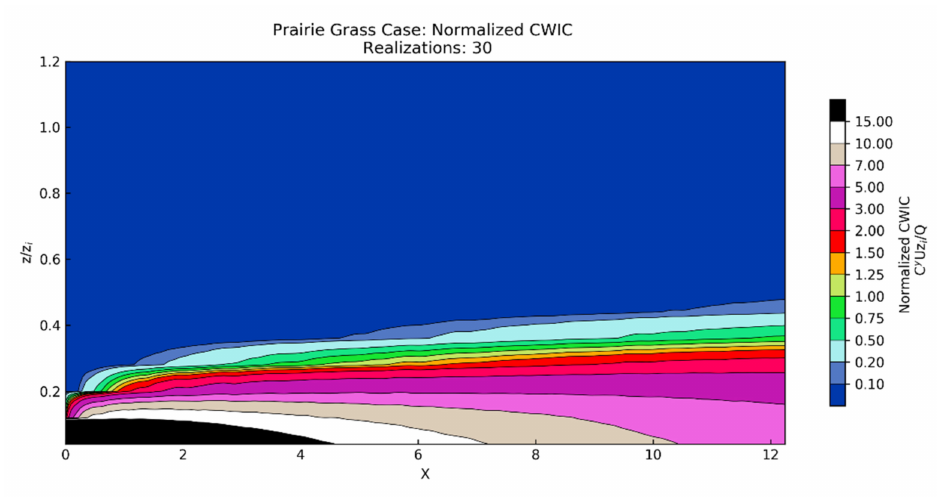
Figure 12. Normalized crosswind integrated concentration as a function of the downwind distance from the release location, for the slightly ( top ), moderately ( middle ), and extremely ( bottom ) sta- ble conditions. Each plot represents the average CWIC from 30 individual GPU-LES dispersion simulation realizations.